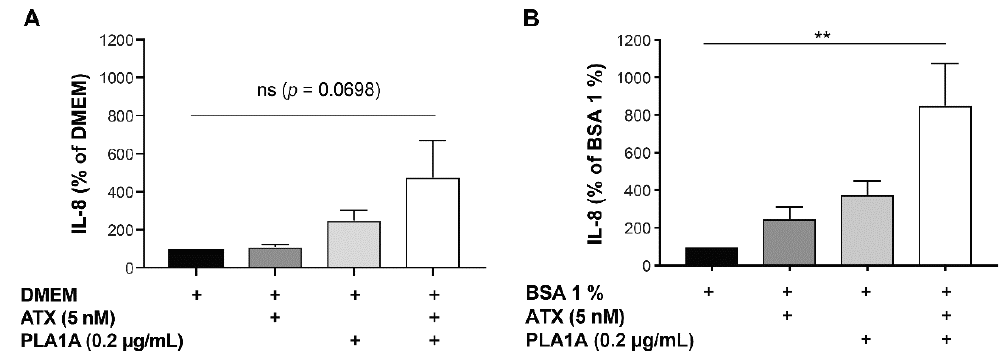
Figure 6. IL-8 production in human primary FLSs stimulated with exogenous PLA1A and ATX. Human primary FLSs from normal donors were stimulated with 0.2 µg/mL recombinant PLA1A in combination with 5 nM recombinant ATX for 24 h, in the absence ( A ) or presence ( B ) of 1% fatty acid-free BSA added in the culture medium. Amounts of IL-8 released in the supernatants were monitored using ELISA. IL-8 produced by FLSs cultured in serum-free DMEM supplemented with or without 1% fatty acid-free BSA was 7.08 ± 2.45 and 8.05 ± 2.04 pg/mL, respectively. For each experiment, basal IL-8 production was set at 100% for data normalization. The data are the means ± SE from five ( A ) and three ( B ) experiments, respectively. For statistical comparative analyses, cytokine amounts in cells stimulated with PLA1A and/or ATX were compared to that in non-stimulated cells. ** p < 0.01.